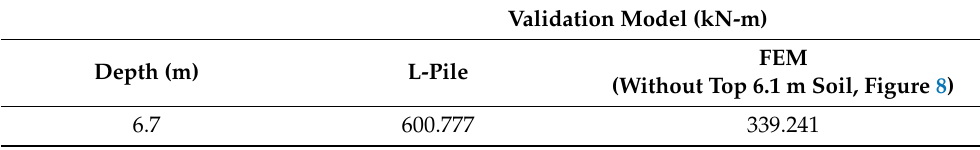
Table 3. Model validation data.